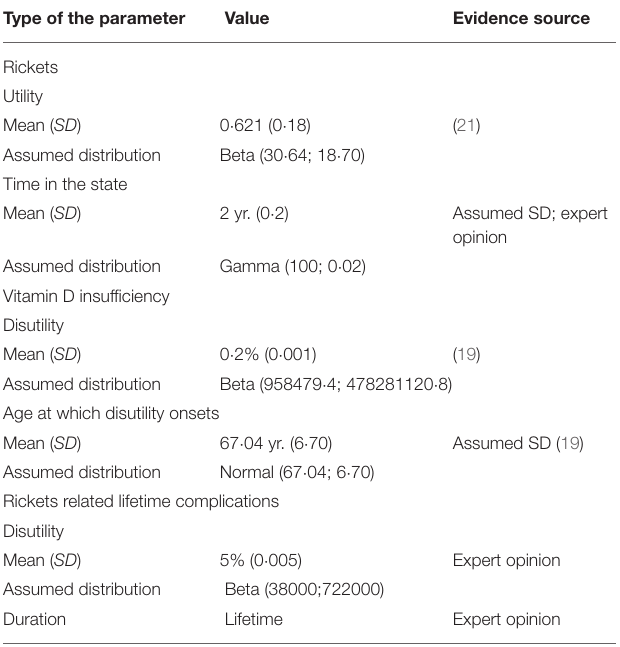
TABLE 1 | Utility estimates used in the decision analytic model.